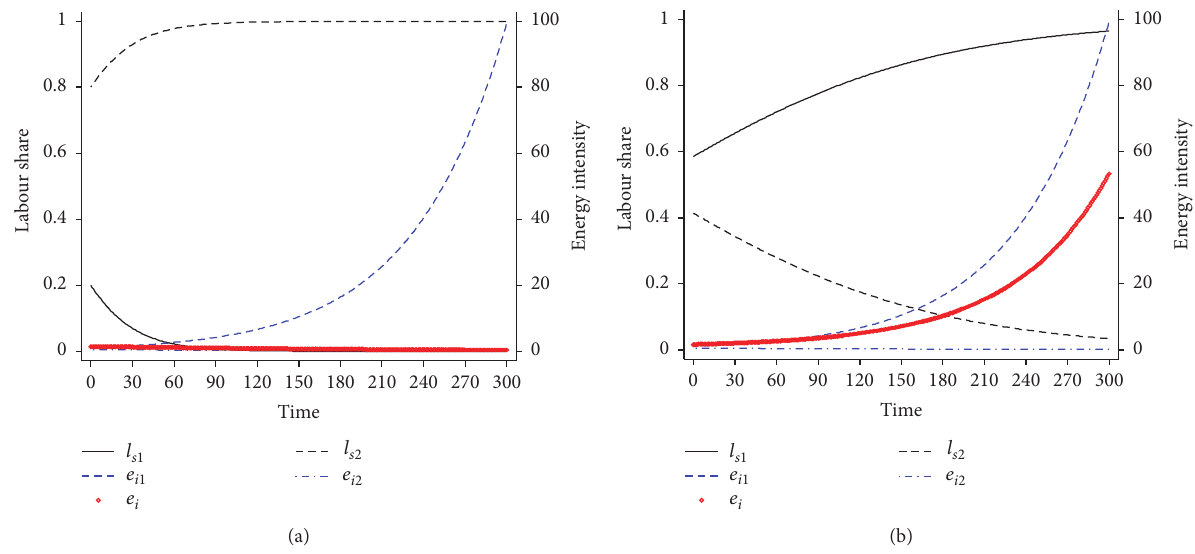
Figure 3: Monotonic change of economy-wide energy intensity with medium energy technological growth rate, (a) 𝜀 = 3 and (b) 𝜀 = 0.5 .